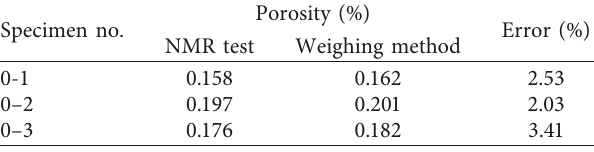
Table 2: The porosity from the NMR test and the weighing method. Specimen no.